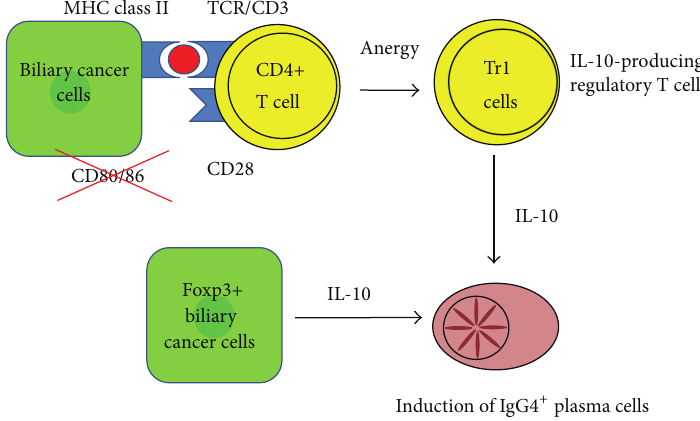
Figure 3: Proposed mechanisms for the induction of IgG4-positive plasma cells in cholangiocarcinoma.